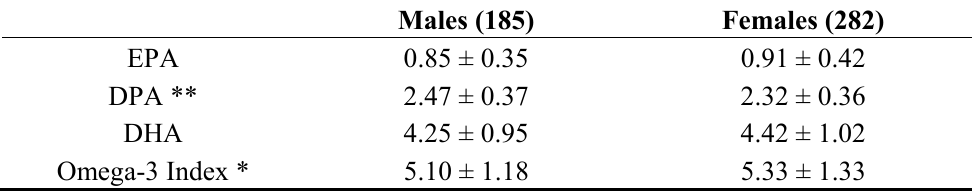
Table 2. Erythrocyte fatty acids (% of total; mean ± SD).